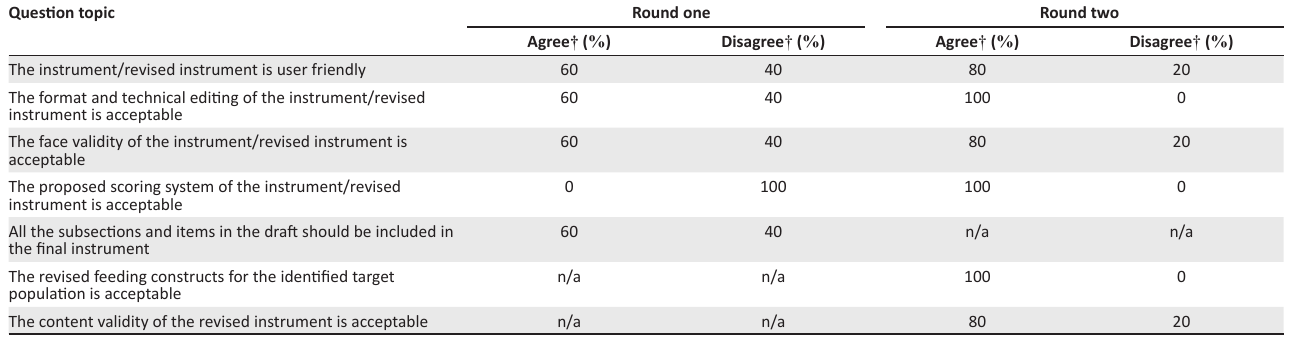
TABLE 5: Quantification of degree of agreement among participants. Question